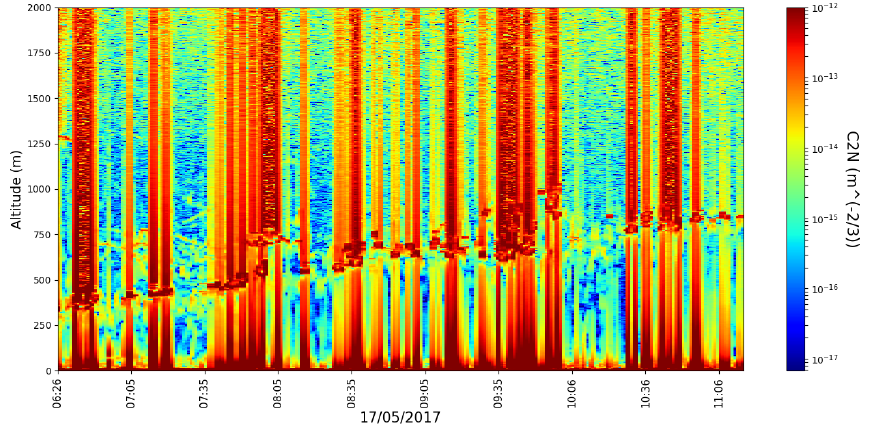
Figure 11. 𝐶 𝑁2 profile timeseries, profiling rate 1/min, 17 April 2017. Figure 11. C 2 profile timeseries, profiling rate 1/min, 17 April N